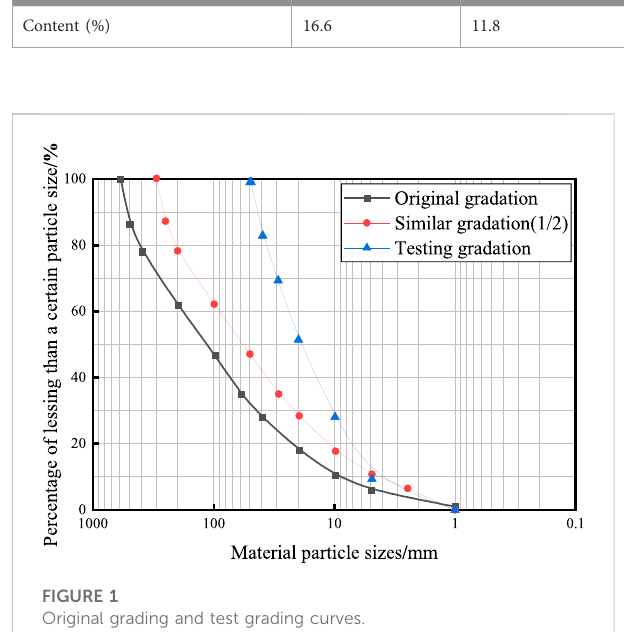
FIGURE 1 Original grading and test grading